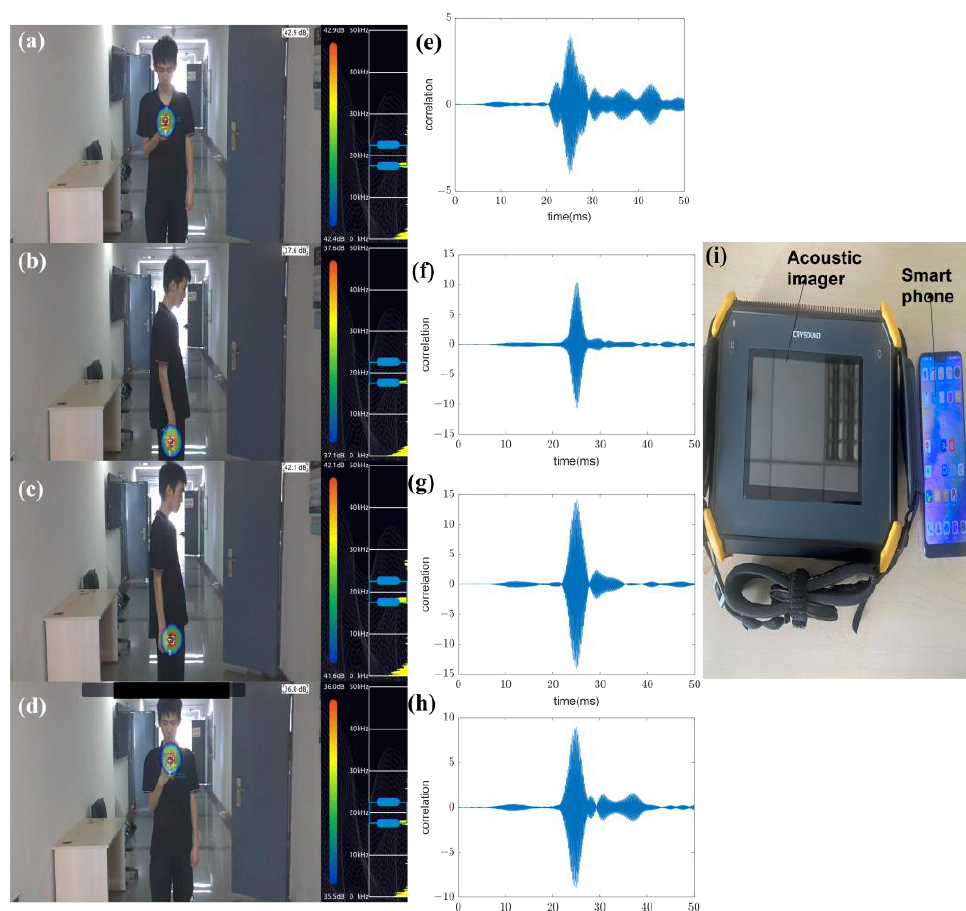
Figure 21. Imaging results of different poses of people holding a mobile phone. ( a ) The phone is held at an angle. ( b ) The phone sags naturally with the arm. ( c ) The phone is in a trouser pocket. ( d ) The angle of the phone is perpendicular to the ground. ( e ) correlation results of Pose ( a ). ( f ) correlation results of Pose ( b ). ( g ) correlation results of Pose ( c ). ( h ) correlation results of Pose ( d ). ( i ) The smartphone and the acoustic imager. Table 2. MAC simulation